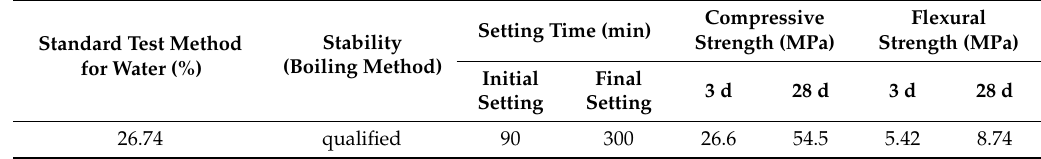
Table 2. Physical properties of the